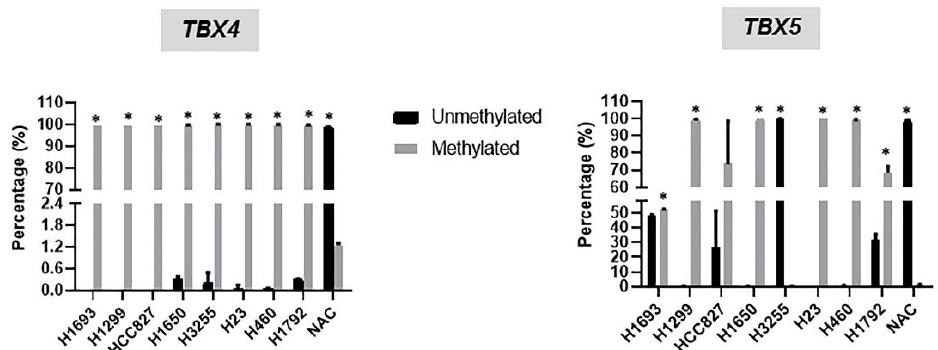
Figure 4. Members of the TBX2 subfamily are hypermethylated in NSCLC cell lines. Methylation levels of members of the TBX2 subfamily were examined in eight NSCLC cell lines and normal alveolar epithelial cells by quantitative methylation-specific PCR using the Epitect Methyl II PCR assay from QIAGEN according to the manufacturer’s instructions (see Section 4). Percentages of un-methylated (UM) and methylated (M) TBX2 subfamily alleles are depicted and represent an average of two experiments (* p < 0.05 comparing methylated versus unmethylated fractions for each cell line).